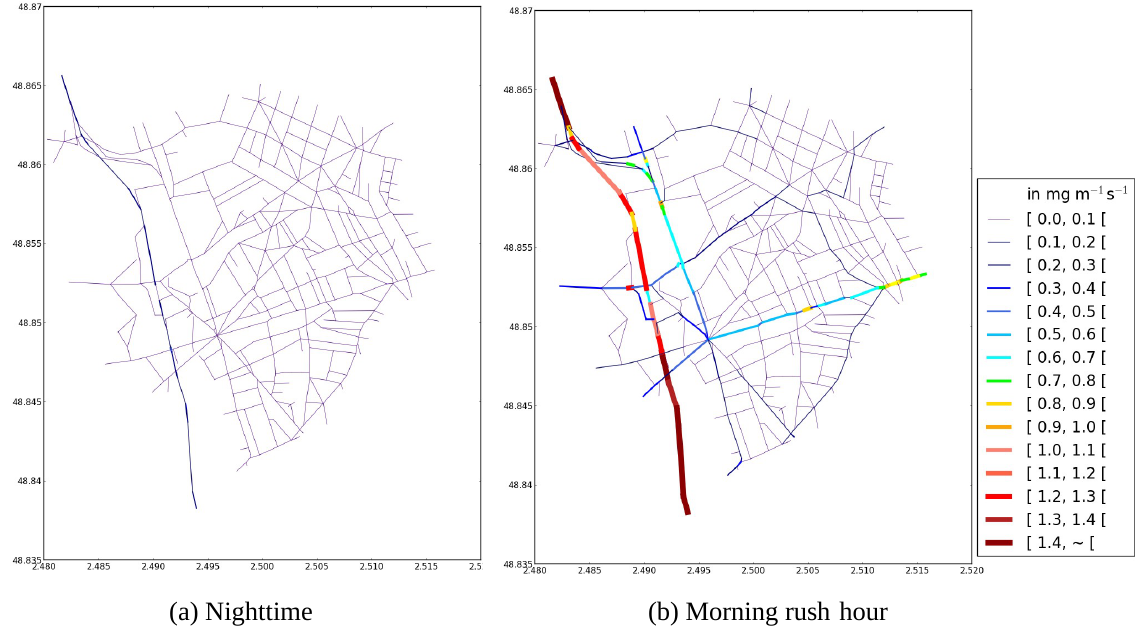
Figure 5. NO x emission rates (mgm − 1 s − 1 ) used in MUNICH simulations for a weekday (a) during nighttime at 01:00UTC and (b) in the morning rush hour at 07:00UTC on 25 March